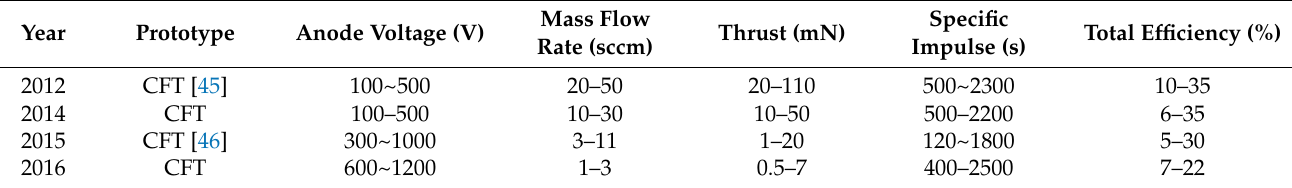
Table 3. Performance of cusped field thruster prototypes in HIT.